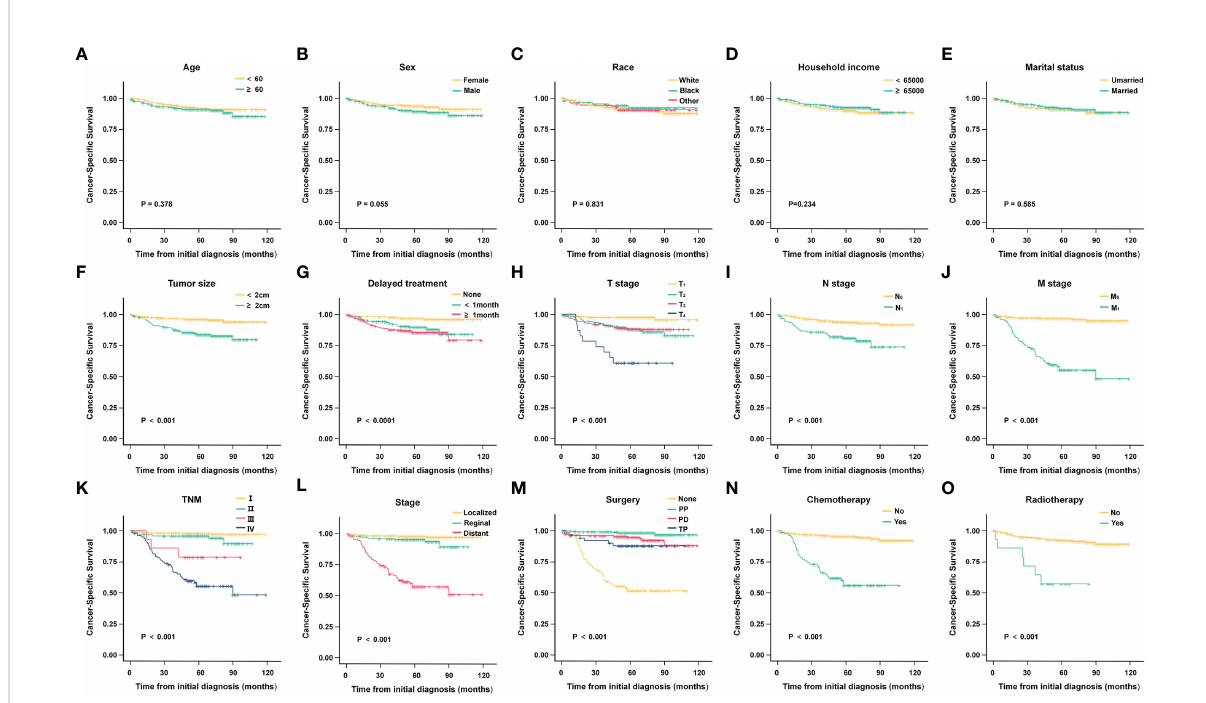
FIGURE 4 Kaplan-Meier analysis of cancer-speci fi c survival (CSS) in different subgroups. (A) Age; (B) Sex; (C) Race; (D) Household income; (E) Marital status; (F) Tumor size; (G) Delayed treatment; (H) T stage; (I) N stage; (J) M stage; (K) TNM; (L) Stage; (M) Surgery; (N) Chemotherapy; (O) Radiotherapy.